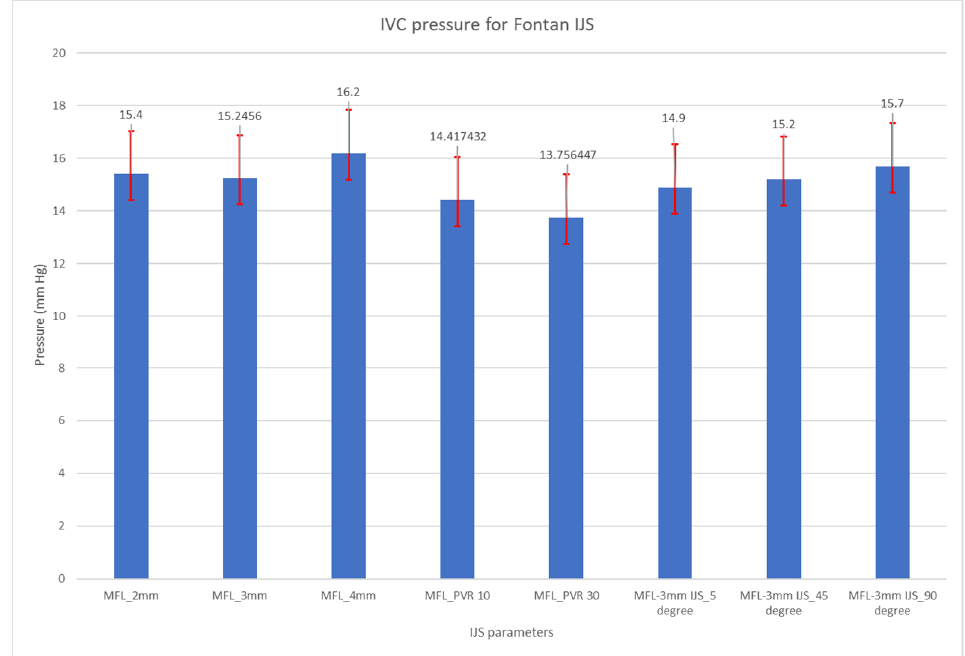
Figure 20. Mean IVC pressure (Pivc) value with the error band.